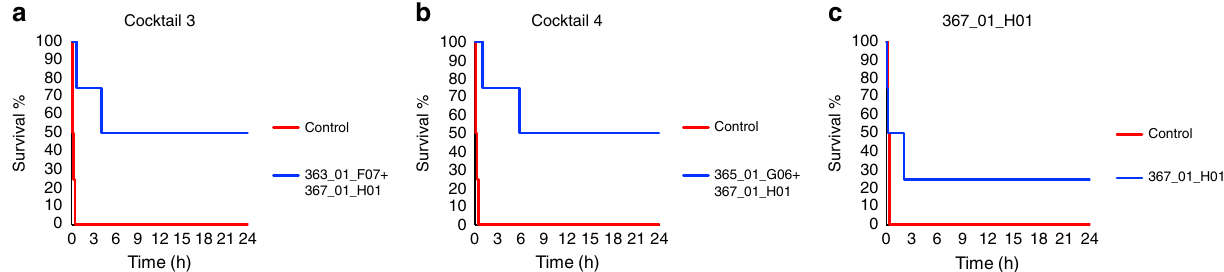
Fig. 5 Kaplan – Meier survival curves for antibody cocktails. Here, shown for a Cocktail 3, b Cocktail 4, and c clone 367_01_H01 against black mamba whole venom administered i.c.v. at an IgG:toxin molar ratio of 3:1. Cocktail 3 contains the IgGs: 363_01_F07 (anti-Dp6) and 367_01_H01 (anti-Dp8). Cocktail 4 contains the IgGs: 365_01_G06 (anti-Dp7) and 367_01_H01 (anti-Dp8). Each individual curve represents survival of a cohort of 4 animals